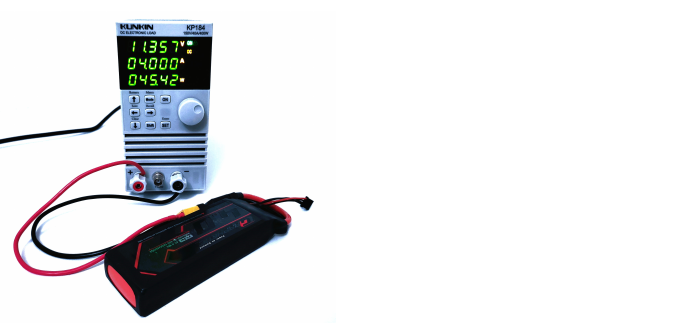
Figure 10. KP-184 programmable electronic load used to characterize the battery employed in the experimental